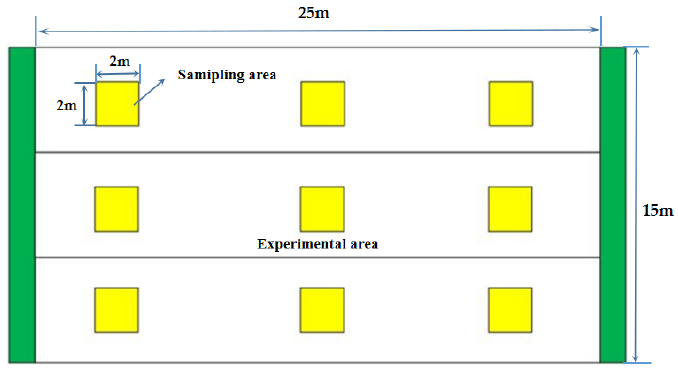
Figure 3. Diagram of the trial field. Table 2. Unit area crop quality record sheet.